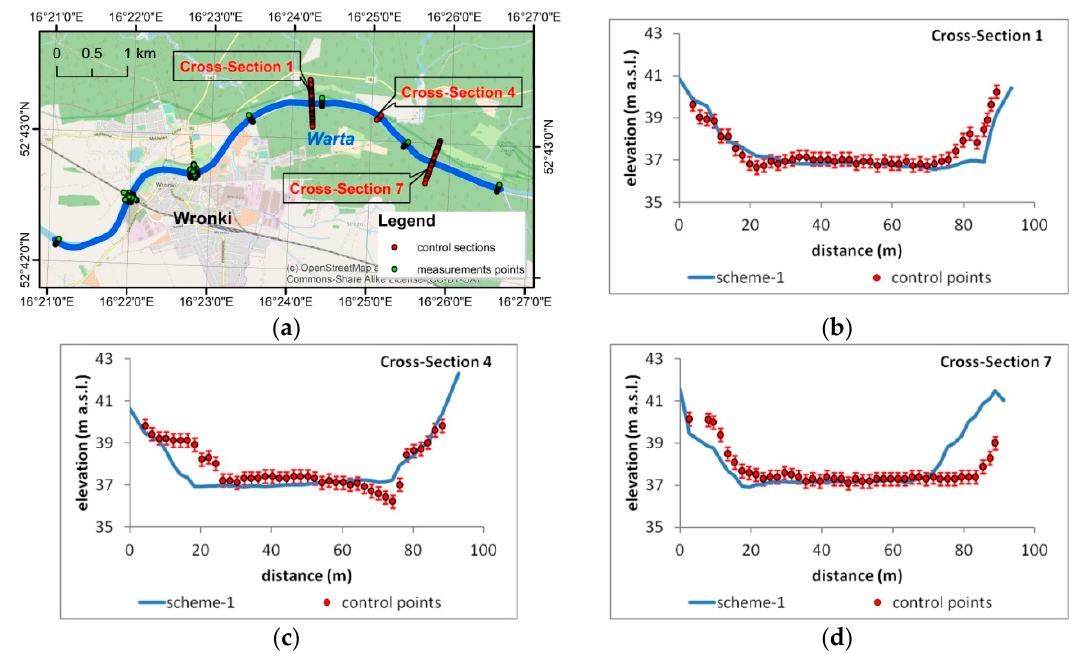
Figure 8. Comparison of the bathymetry interpolated with the first algorithm and control cross-sections: ( a ) location of control cross-sections; ( b – d ) results of comparison.